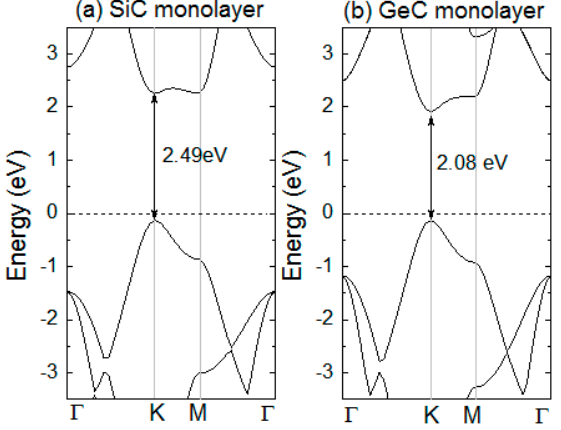
Figure 2. (Color online) Band structures of primitive ( a ) SiC and ( b ) GeC monolayers. The Fermi level is marked by the dashed line.